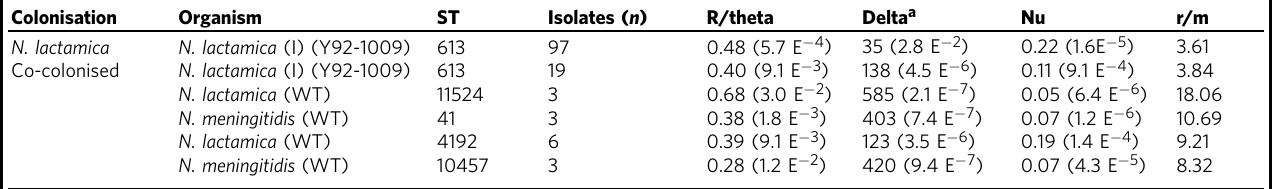
Table 3 Relative recombination effect (r/m) of isolates in colonised volunteers and the parameters used to infer them